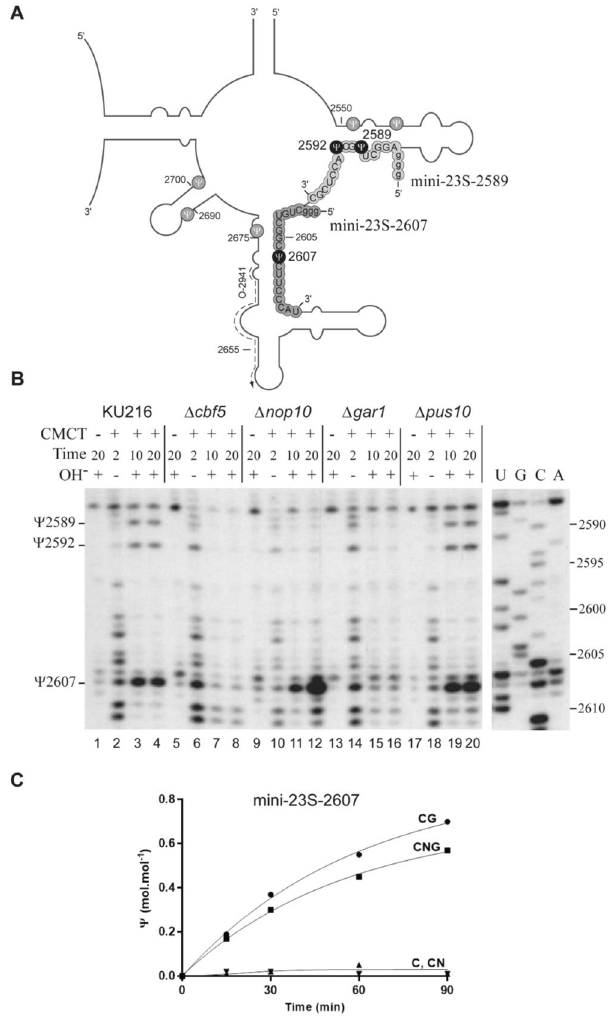
Figure 3. The effect of gene disruption on Ψ formation in the domain V of T . kodakarensis 23S rRNA. ( A ) Ψ s identified in this work in the T . kodakarensis 23S rRNA, which are conserved in the P . abyssi 23S rRNA are indicated by black dots. The grey dots correspond to other Ψ s detected in P . abyssi 23S rRNA in a previous work 55 . The secondary structure of the T . kodakarensis 23S rRNA is adapted from Piekna et al . 16 . The sequence of the two substrates mini–23S–2607 and mini–23S–2589, synthesized by in vitro transcription and used in vitro in Panel C (mini–23S–2607) and in Fig. 5 (mini–23S–2589), is highlighted. ( B ) Identification of Ψ s in the T . kodakarensis 23S rRNA by the CMCT-RT method. As indicated at the top of each lane, total RNAs extracted from the various T . kodakarensis strains were treated in the absence ( − ) or the presence of CMCT ( + ), for 2, 10, and 20 min as described in Methods. The CMCT treatment was ( + ) or was not ( − ) followed by an alkaline treatment at pH 10.4. The positions of Ψ s were identified by primer extension analysis using oligonucleotide O-2941 (represented by the dashed arrow) as described in Methods. Digital image of the autoradiogram was obtained by scanning the x-ray film. The presence of Ψ s is revealed by the appearance of alkali-resistant RT stops. Lanes U, G, C, and A correspond to the RNA sequencing ladder. The positions of nucleotides in 23S rRNAs are indicated to the left of the autoradiogram. The two panels correspond to a cropping of two sections of the same autoradiogram. The full-length gel is presented in Supplementary Figure S4. ( C ) Time course analysis of in vitro modification by recombinant proteins in RNA substrate mini–23S–2607. The RNA substrate was radiolabeled by the incorporation of [ α - 32 P]CTP during in vitro transcription. The RNA was incubated with different protein combinations: Cbf5 alone ( C ), Cbf5 and Nop10 (CN), Cbf5, and Gar1 (CG), and a set of the three proteins (CNG). At each time point, an aliquot of the reaction mixture was analyzed by 2D-TLC. The radioactivity was quantified by PhosphorImager analysis. The quantities of Ψ nucleotides formed are expressed in moles per mole of